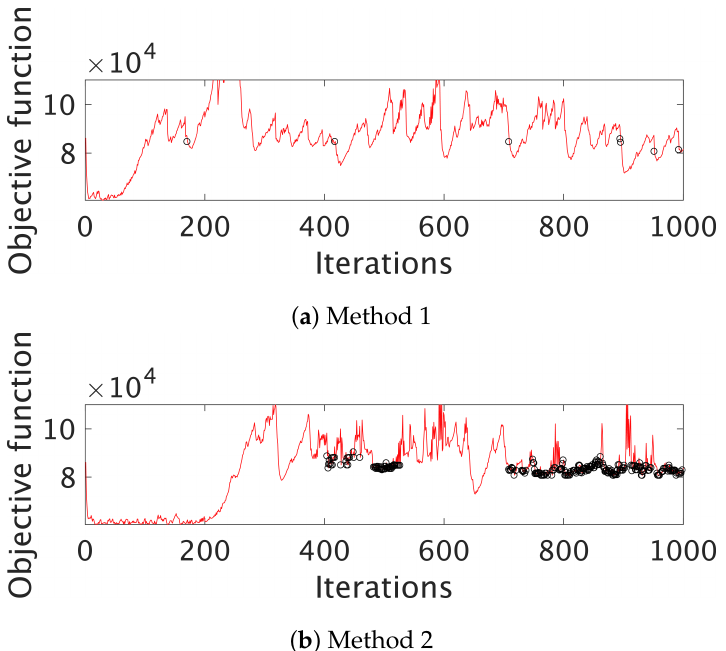
Figure 6. Temporal changes in the process for searching objective function values in ( a ) Method 1 and ( b ) Method 2 when solving the mBSSRP-S ( n = 30). Black circles represent when the method finds feasible solutions of the mBSSRP. Results show that Method 2 finds more feasible solutions than Method 1 during 1000